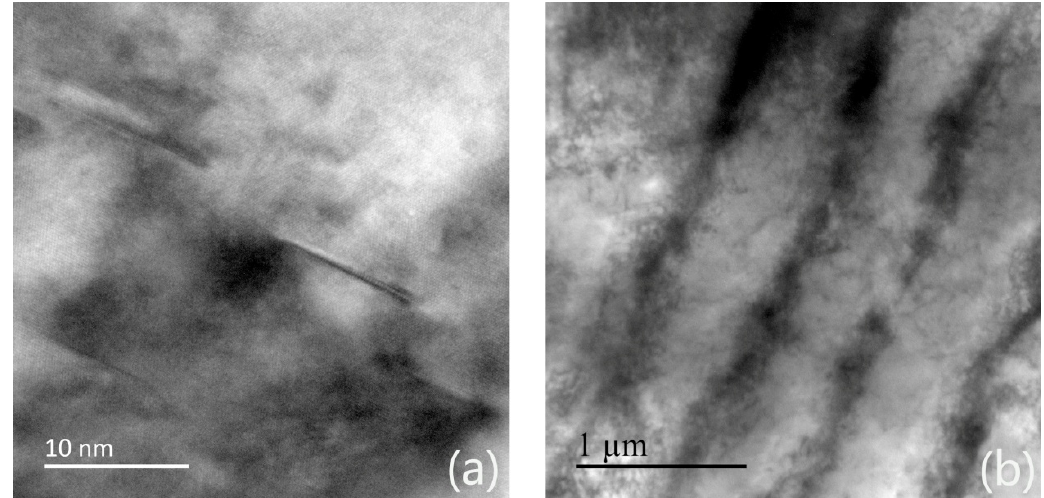
Figure 11. ( a ) TEM observation of the stacking faults in the as-deposited condition; ( b ) dislocations in the as-deposited